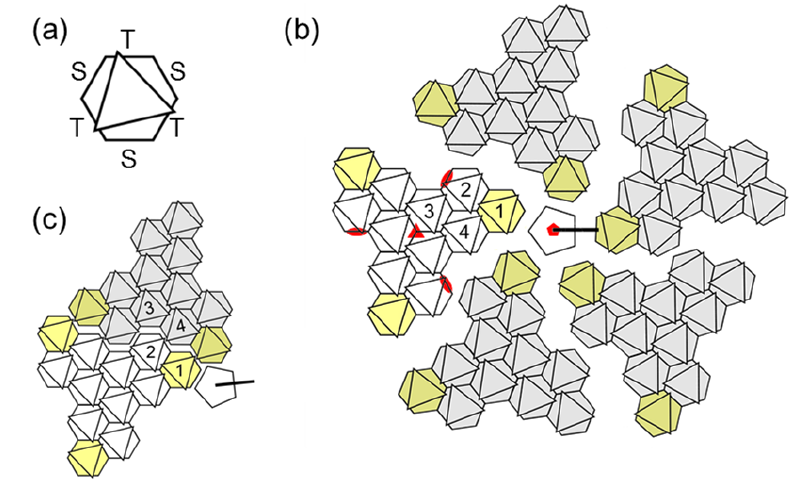
Figure 2. Geometrical landmarks in the AdV icosahedral net. ( a ) Each hexon trimer is depicted as a hexagon with an overlaid triangle indicating the position of the towers. The two different kinds of faces in the hexon pseudo-hexagonal base are labeled S (single monomer) and T (two monomers). ( b ) One penton and the five adjacent facets are represented, spread out for clarity. The four hexon trimers forming the asymmetric unit (AU) are numbered in one facet. Peripentonal hexons, forming the Group of Six (GOS) together with the penton, are highlighted in yellow. Hexons in the Groups of Nine (GON) are depicted in white for the reference facet, gray in the rest. Red symbols indicate the icosahedral symmetry axes. Notice that there is an alternative way to define the AU, in which hexons belonging to two facets would be included ( c ). This alternative AU was used in the atomic resolution cryoEM